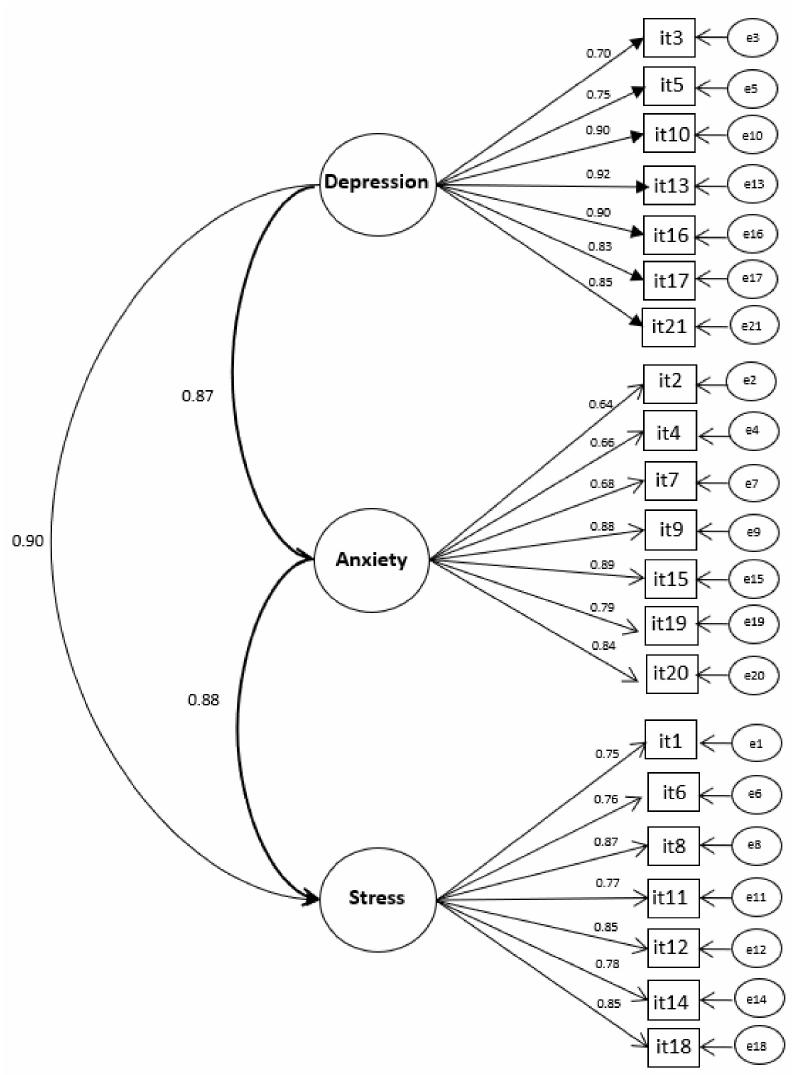
Figure 1. Factorial model of the Depression, Anxiety and Stress Scale for the sample.